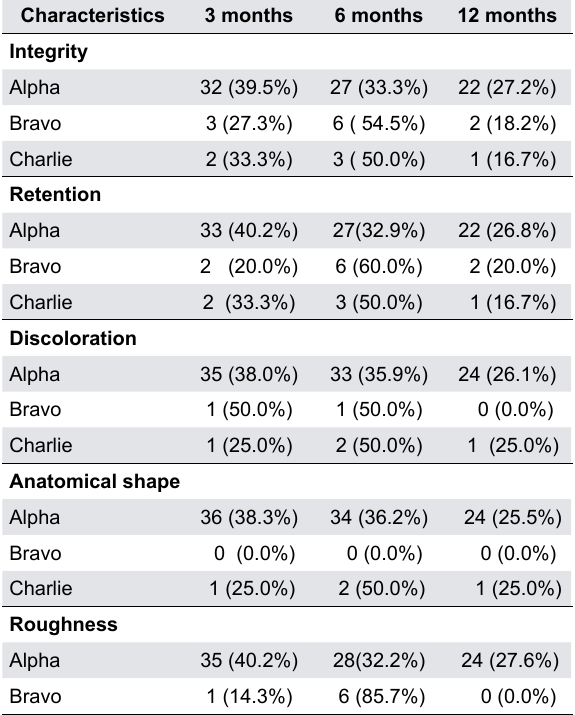
Characteristics